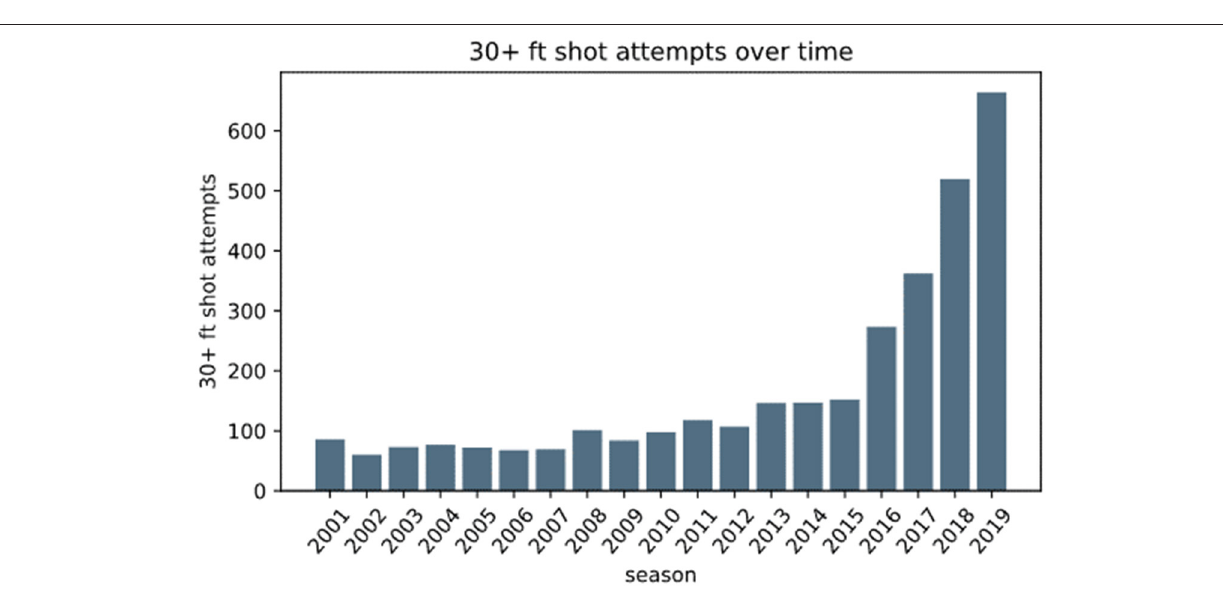
FIGURE 5 | Shift in the number of attempted three-point shots from > 30 feet away from the basket goal in NBA (Cheema, 2019), reprinted with the author’s